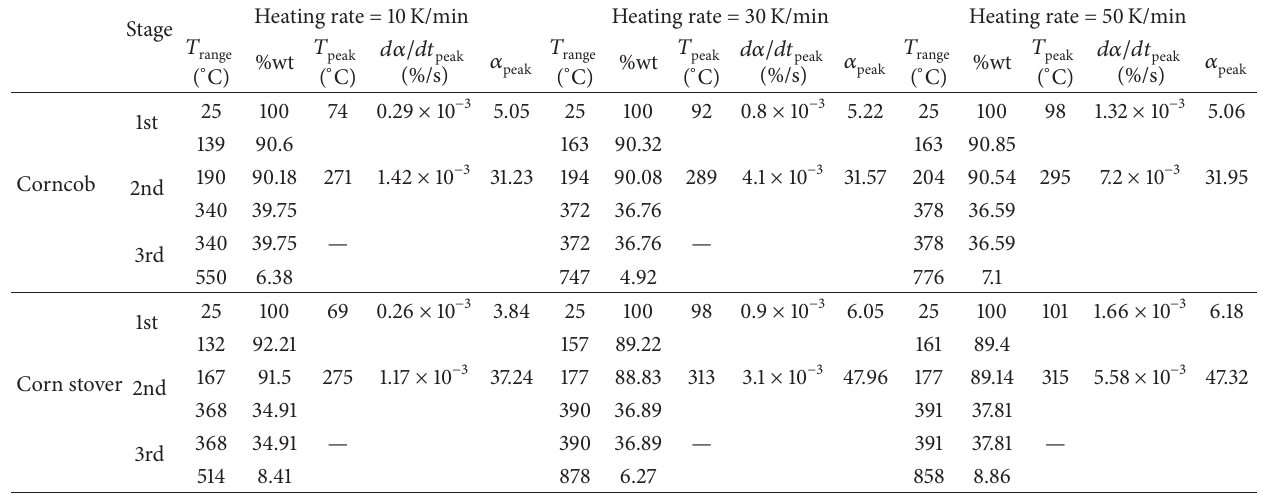
Table 2: Thermal degradation characteristics of corn residues under oxygen atmosphere. Heating rate = 10K/min Heating rate = 30 K/min Heating rate = 50 K/min Stage